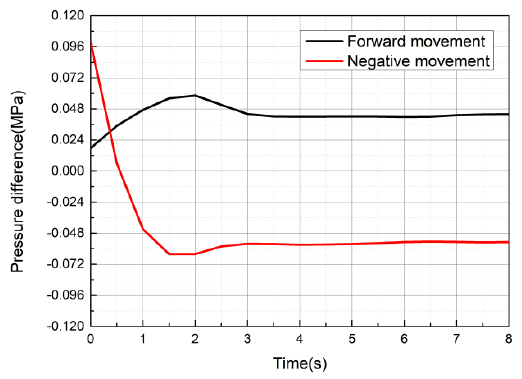
Figure 14. Pressure difference graph.